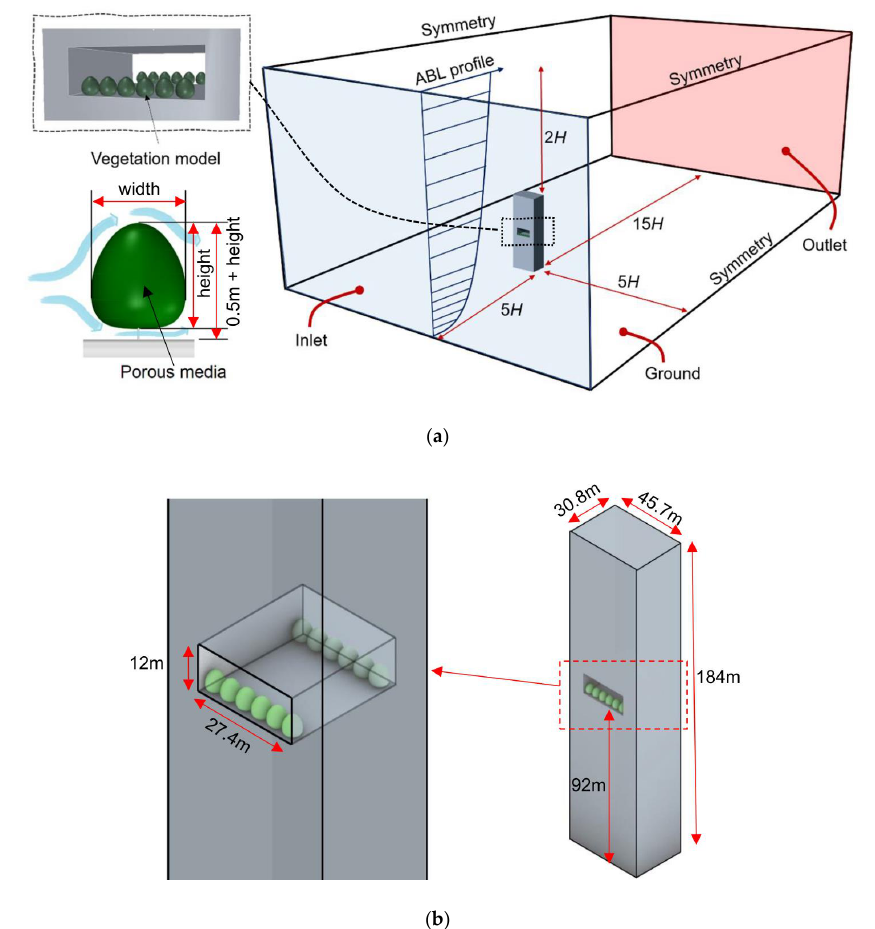
Figure 2. ( a ) Example of the computational domain and boundary conditions (large trees); ( b ) skygarden model and schematic showing dimensions.